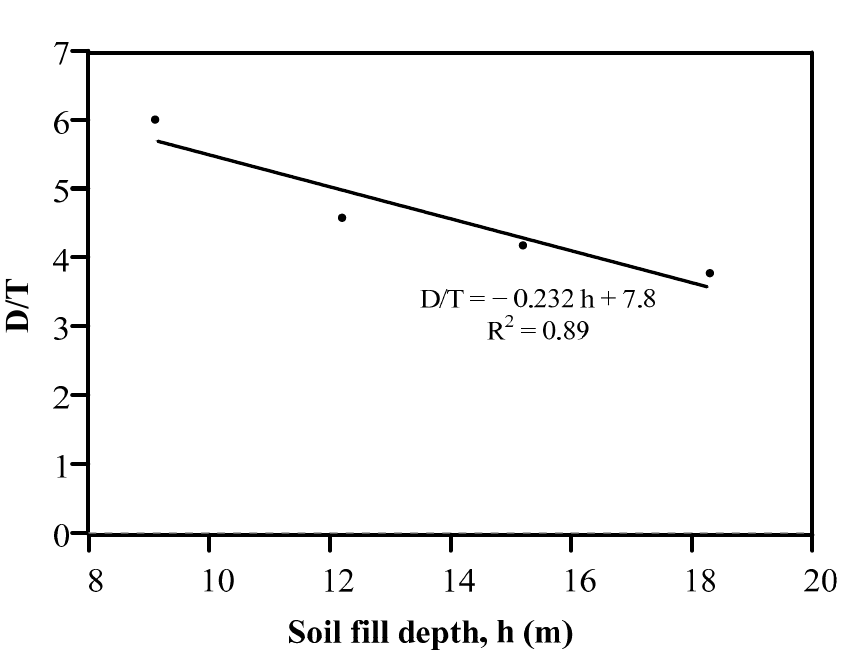
Figure 8. Soil fill depth versus optimum D/T ratio.